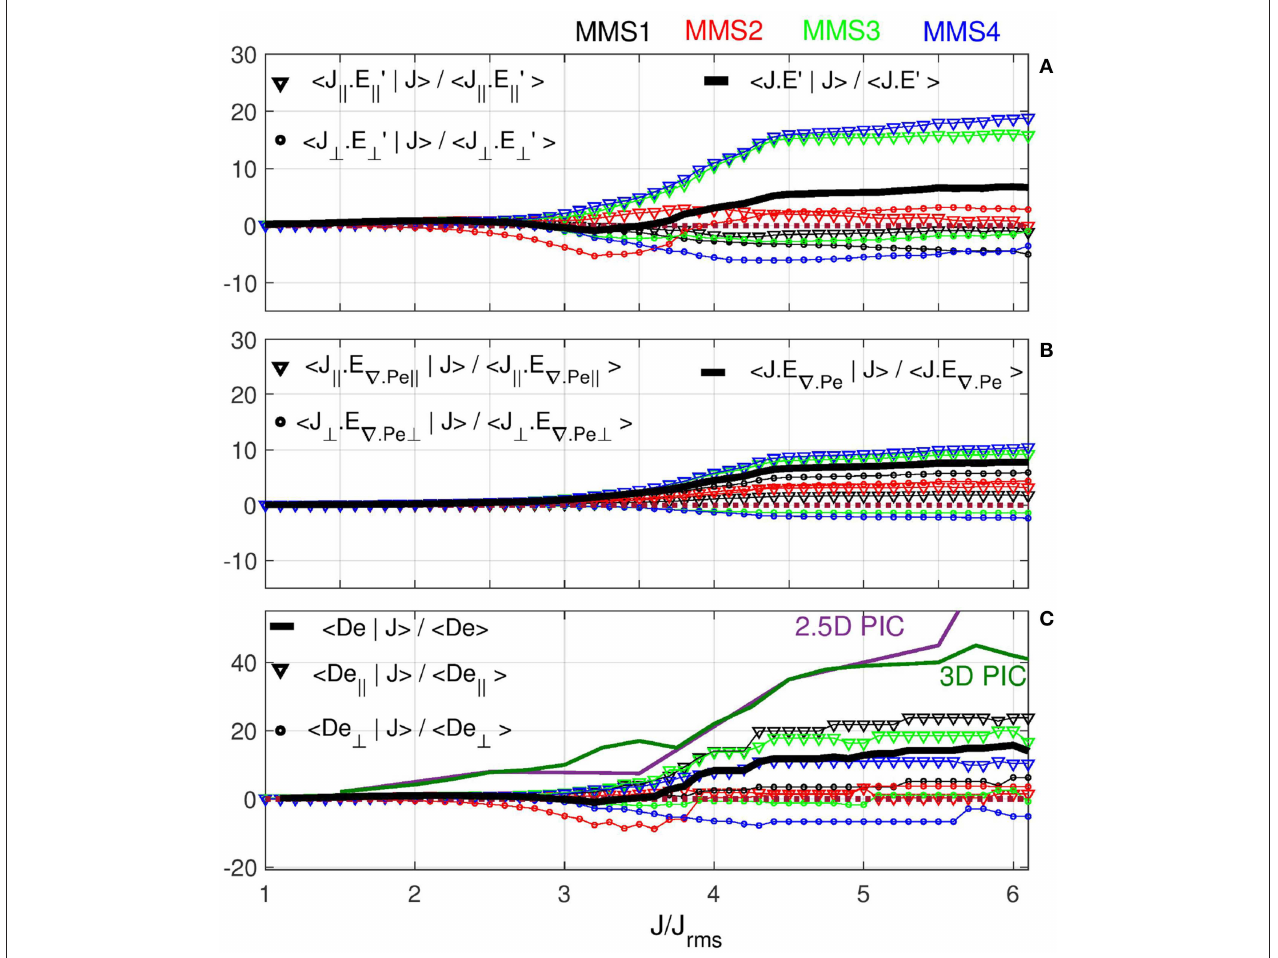
FIGURE 4 | (A–C) Normalized current density J / J rms (rms = root mean square) versus conditional temporal averages of normalized EED measures calculated by conditioning on the values of current density J . The color code in each subplot corresponds to the spacecraft MMS1-4. The triangles show the parallel and the circles the perpendicular products. The thick black lines represent temporal and spatial averages between MMS1-4. In subplot (C) the results from 2.5D and 3D PIC simulations are shown (Wan et al.,